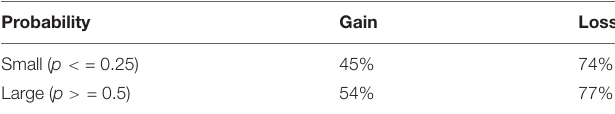
TABLE 3 | Percentage of Risk Seeking choices for small and large outcome probabilities in gain and loss conditions. Probability Gain Loss Small ( p < = 0.25)